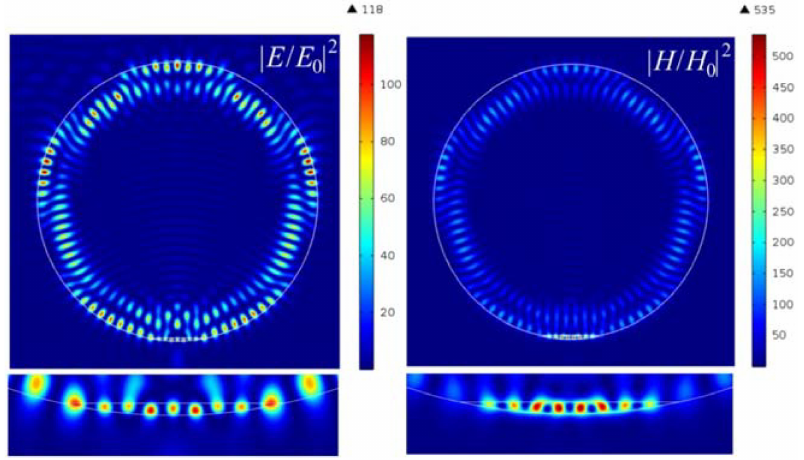
Figure 6. Hot-spot generation in cylindrical Janus particle with the parameters h = 58 nm and n = 0.476.